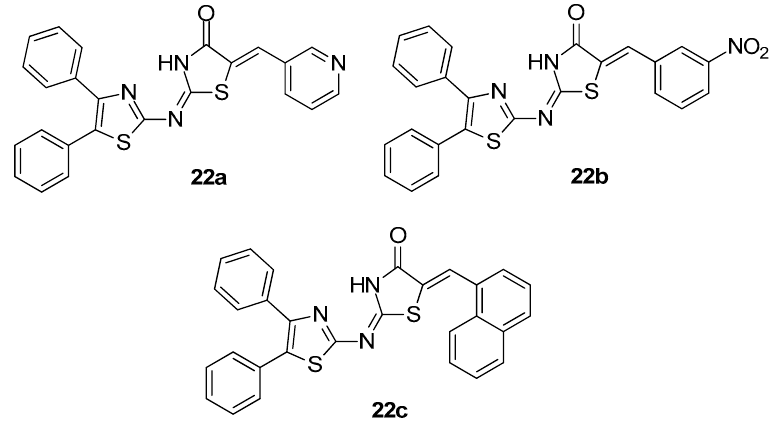
Figure 24. Chemical structures of diphenylthiazole–thiazolidinone hybrids 22a – c .